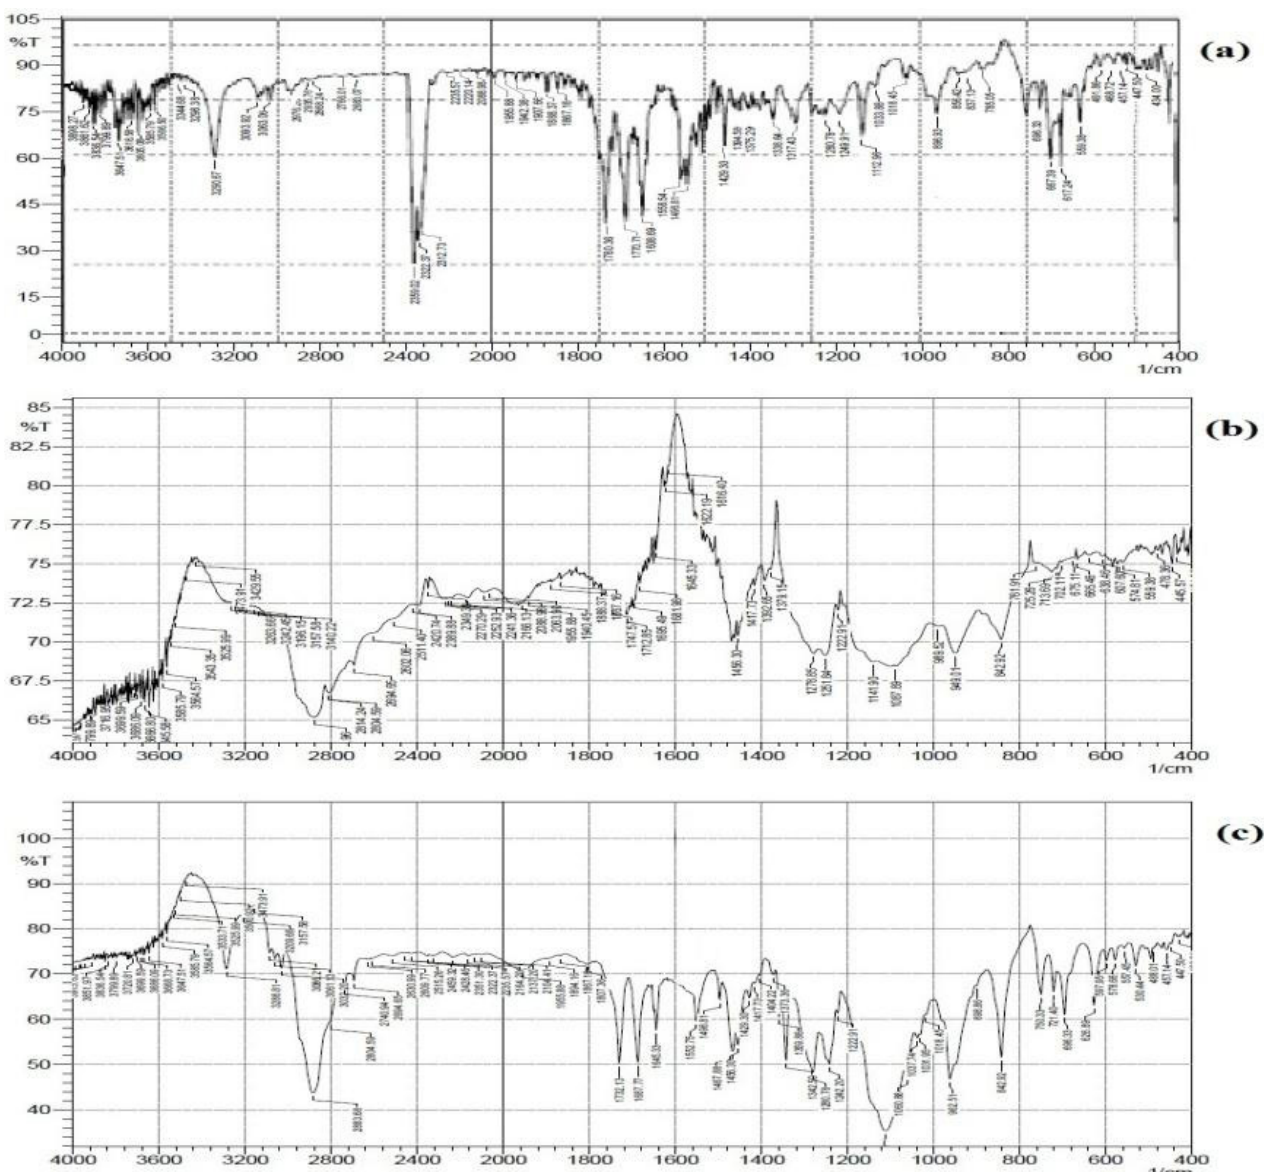
FIGURE 2 - Fourier transform infrared spectrum of a) RT b) conventional direct compression physical mixture c) optimized F12 liquisolid